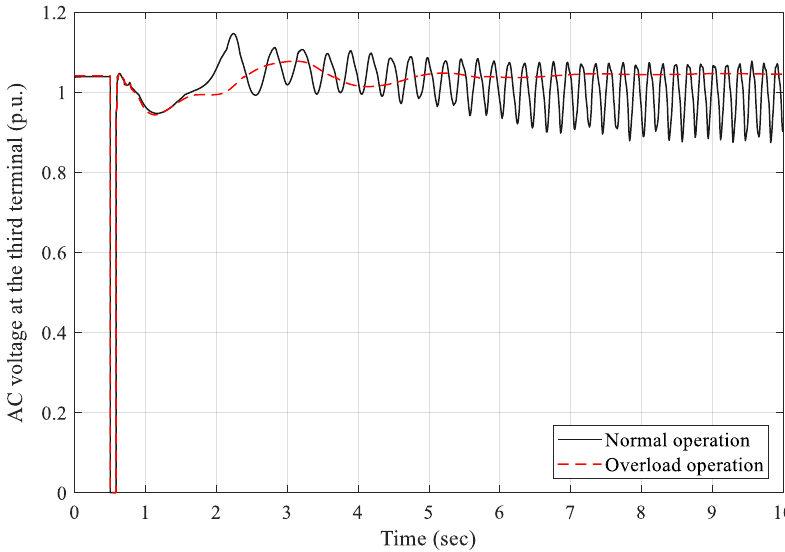
Figure 25. The AC voltage at the third terminal for each case in the actual system data.